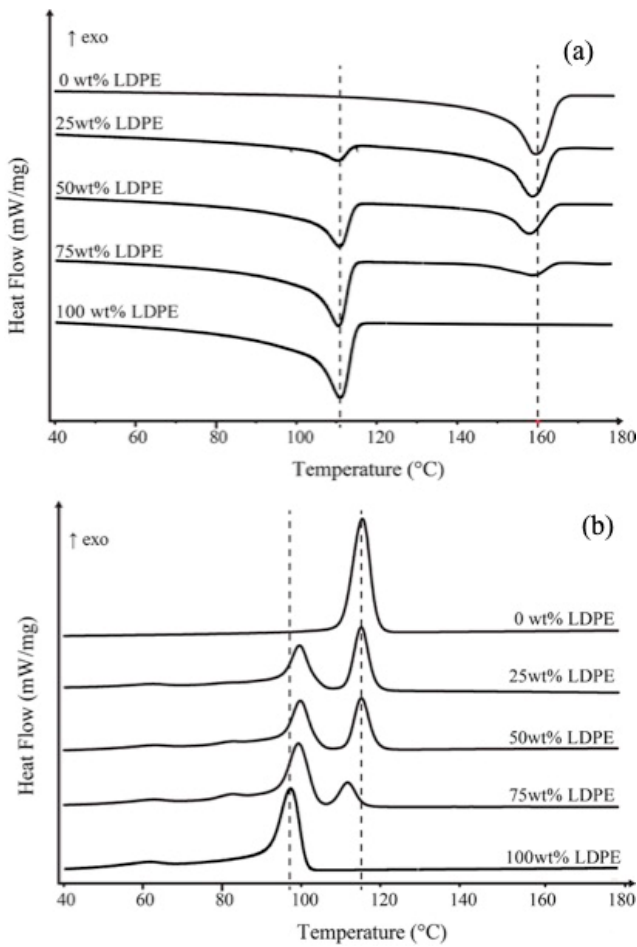
Figure 1. ( a ) Melting temperature ( T m ) from the 2nd heating scan and ( b ) crystallization temperature ( T c ) of polypropylene (PP), low-density polyethylene (LDPE) and their blends at different compositions.